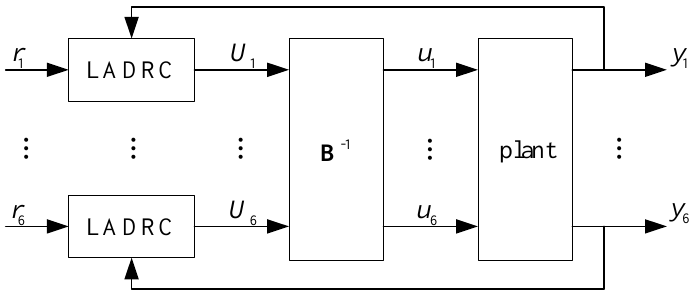
Figure 4. The diagram of a MIMO system controlled by LADRC.